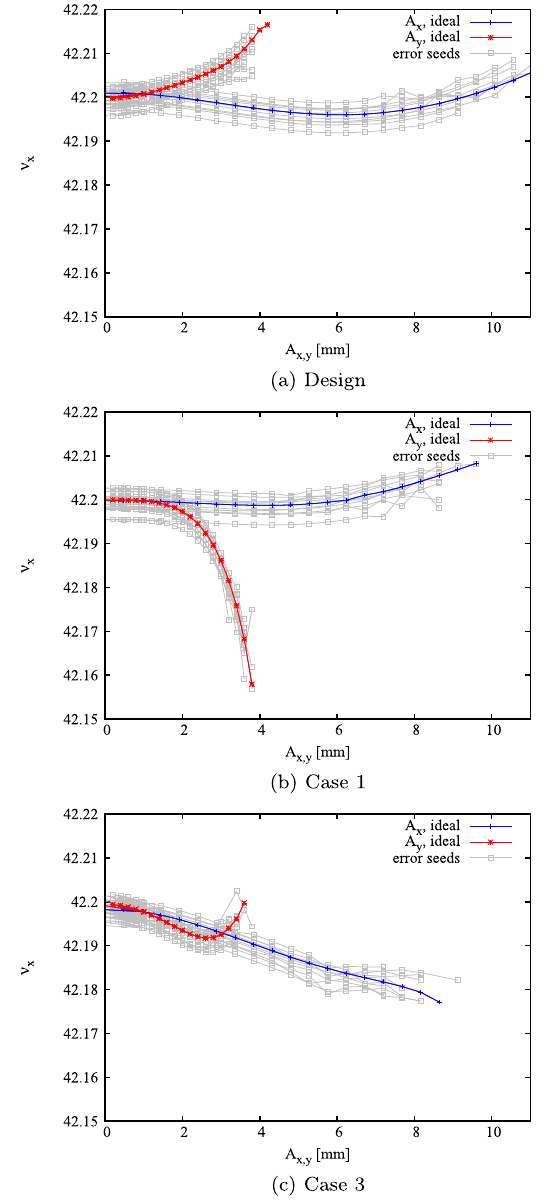
FIG. 14. Amplitude dependent tune shifts [horizontal tune ( ν x )] for the design lattice and Case 1 and 3 SCVDB lattices, adjusted ¼ 6 . 6 pm rad without errors. Ideal lattice in blue for E II (horizontal) and red (vertical). Ten error seeds in gray.